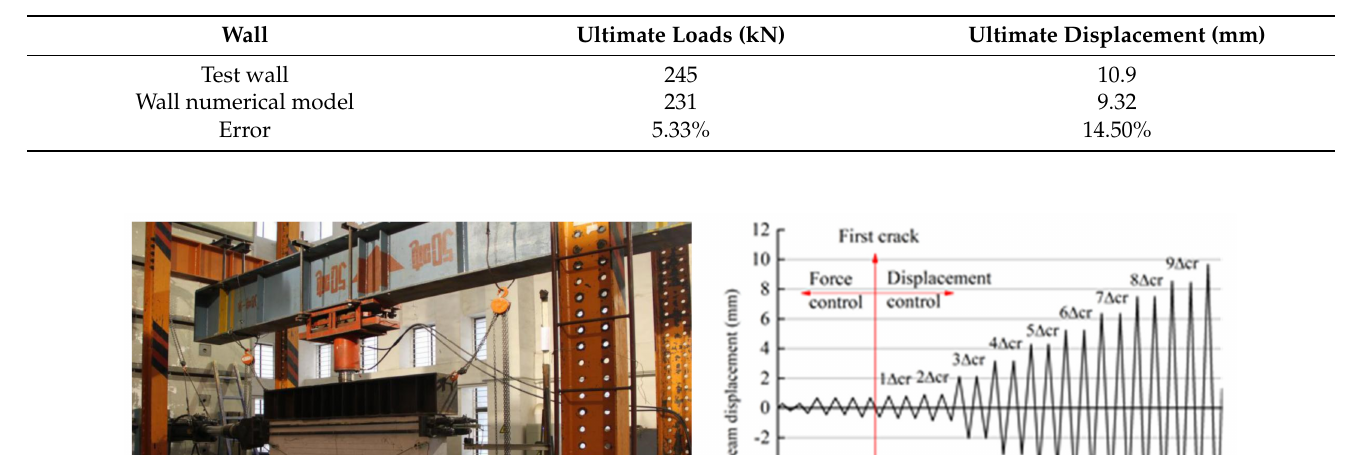
Figure 12. Detailed diagram of assembly masonry wall: ( a ) wall dimensions ( b ) constructional reinforcement. Table 3. Ultimate loads and displacements of the walls.